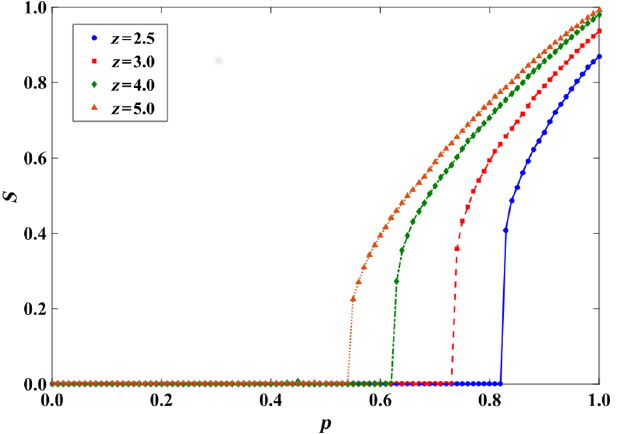
FIG. 6. Comparison between simulation results of the RMCGC for a multiplex network with M ¼ 3 Poisson layers with average degree z and no link overlap, and the message- passing results over single-network realization and given configuration damage. We consider different values of the average degree z ¼ 2 . 5 , 3.0, 4.0, 5.0. Points indicate results of numerical simulations: blue circles ( z ¼ 2 . 5 ), red squares ( z ¼ 3 . 0 ), green diamonds ( z ¼ 4 . 0 ), and orange triangles ( z ¼ 5 . 0 ). Message-passing predictions are denoted by lines with the same color scheme used for numerical simulations. Simulation results are performed on a single instance of a multiplex network with N ¼ 10 4